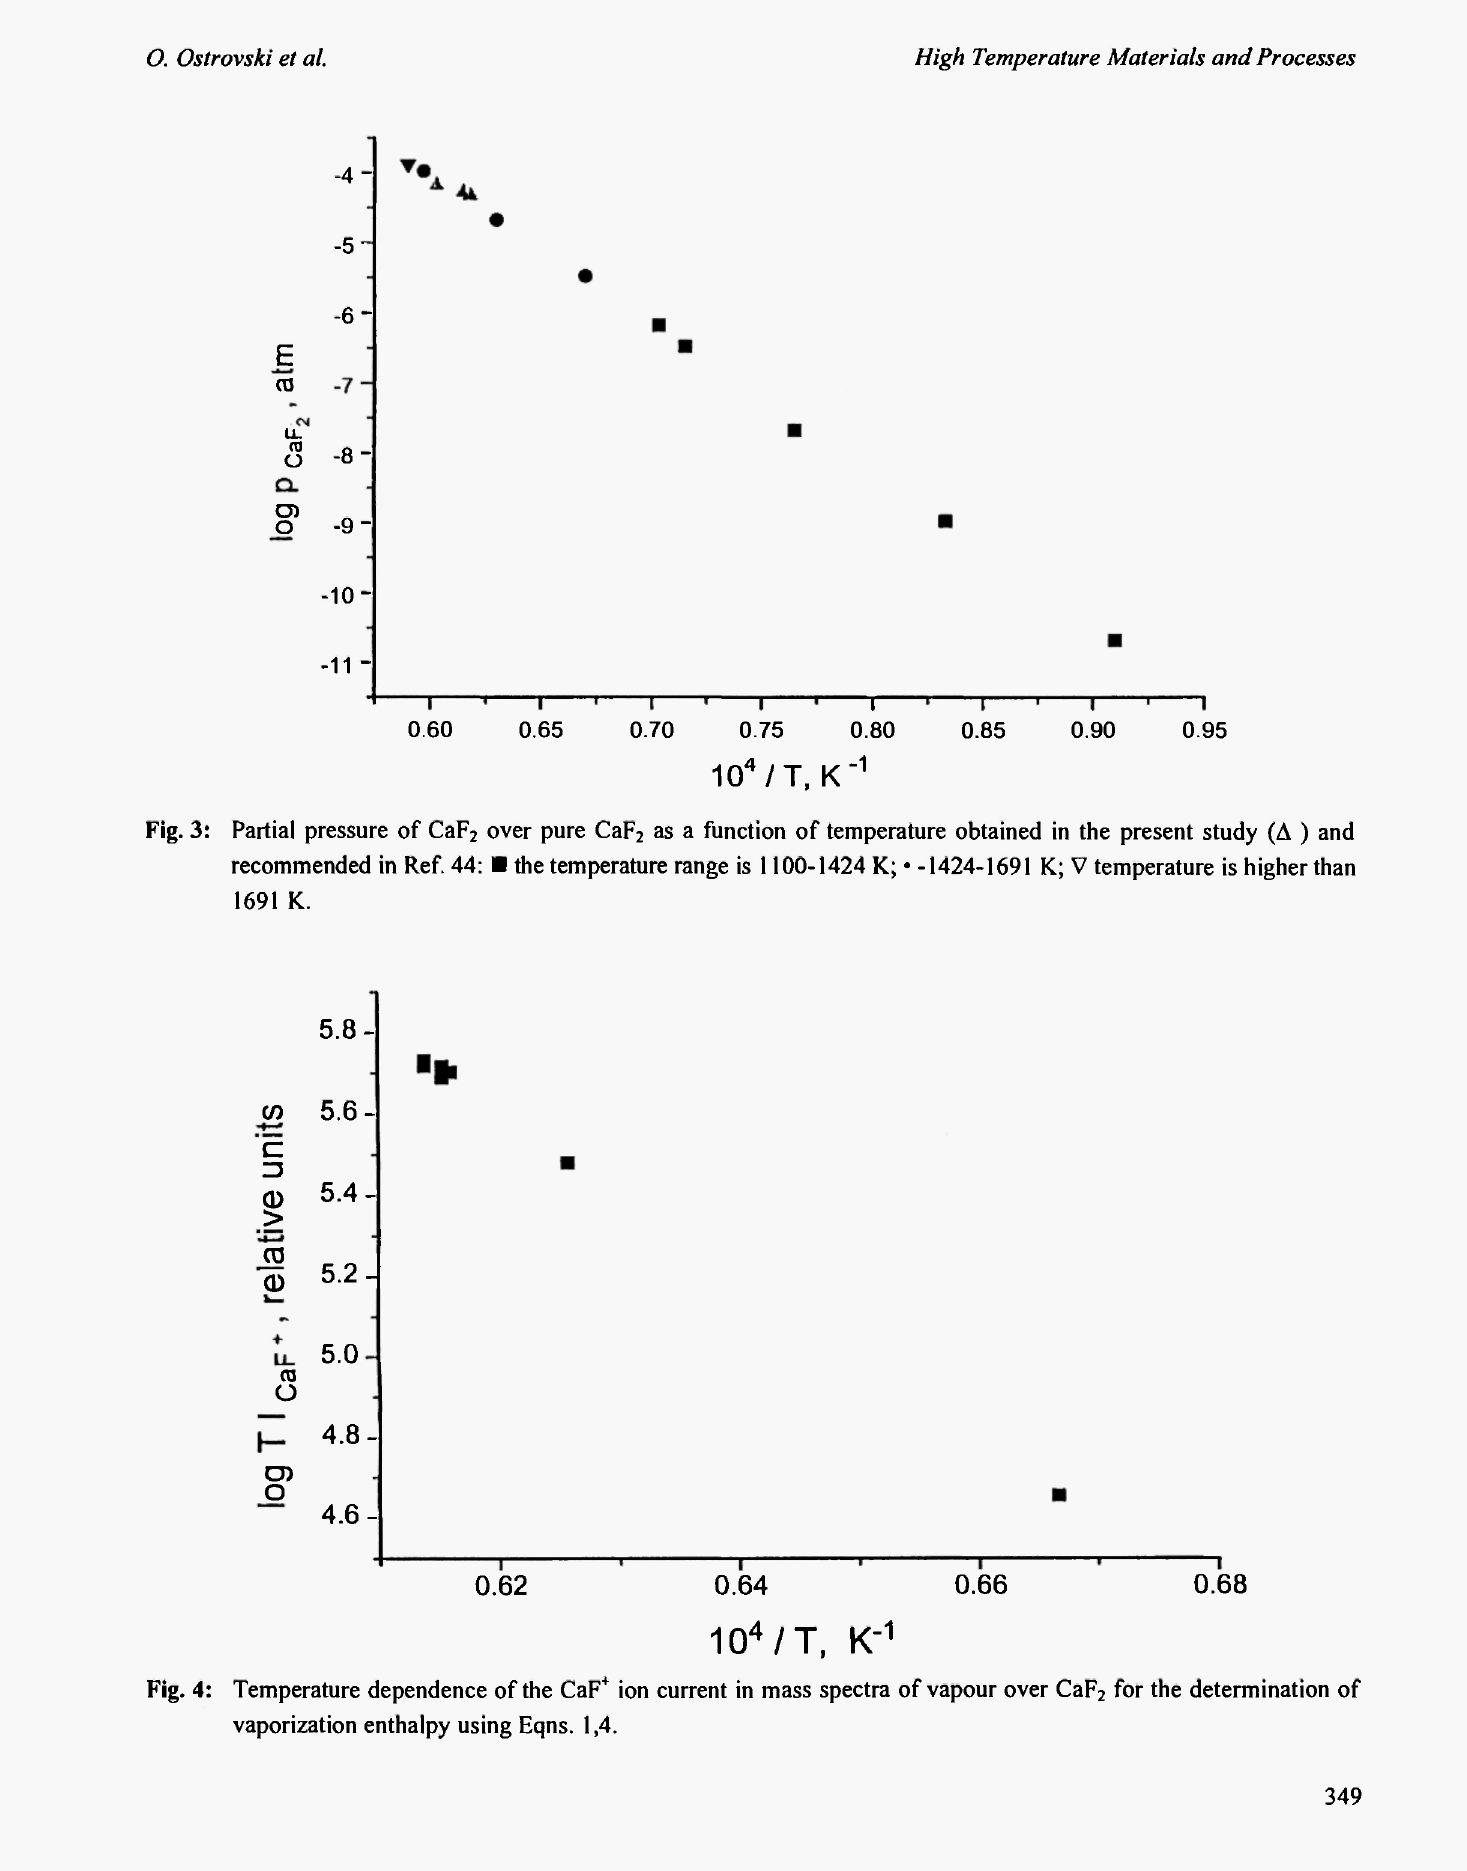
Fig. 4: Temperature dependence of the CaF + ion current in mass spectra of vapour over CaF 2 for the determination of vaporization enthalpy using Eqns.